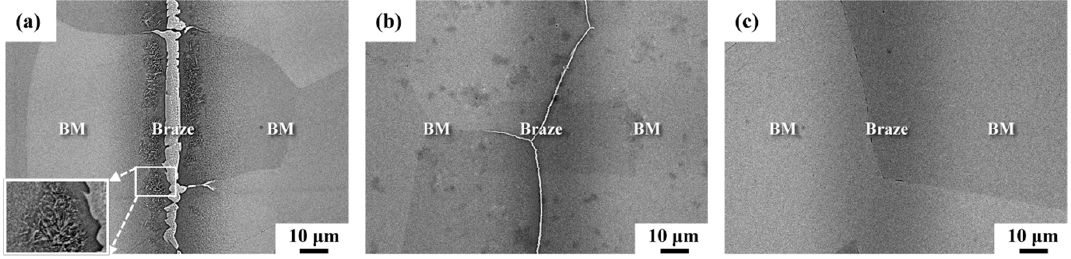
Figure 4. BSE-SEM micrographs of ( a ) B3, ( b ) B10 and ( c ) B30 samples.